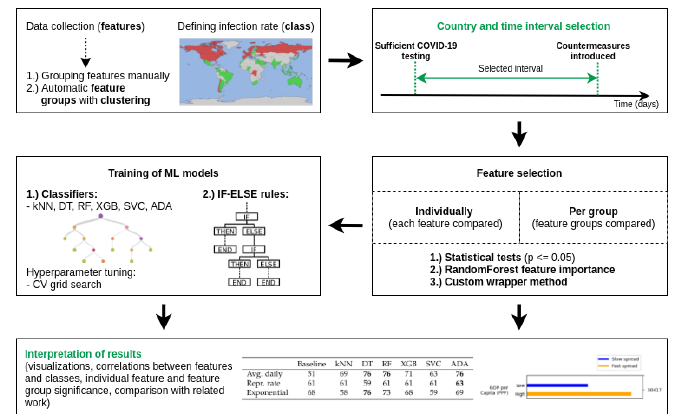
Figure 1. The overview of the research presented in this paper. Green titles indicate highlights of the presented